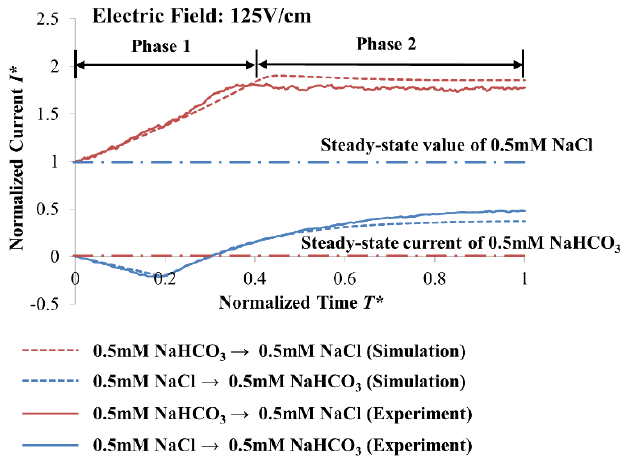
Figure 4. Electroosmotic displacement flow of the 0.5 mM NaCl–NaHCO 3 solution pair at the applied electric field of 125 V · cm − 1 , whereby numerical simulation and experimental results are compared. Normalized currents and times are calculated with I* = ( I − I 0 NaHCO 3 )/( I 0 NaCl − I 0 NaHCO 3 ) and T* = T / T SS NaCl → NaHCO 3 respectively, where initial currents of solutions are represented by I 0 with NaHCO 3 and NaCl subscripts respectively, and time to reach steady-state current for NaCl → NaHCO 3 (arrow indicates EOF direction) is represented by T SS NaCl → NaHCO 3